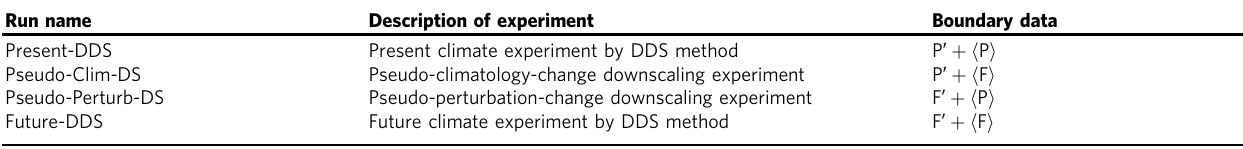
Table 1 Experimental design for estimating the contributions of climatology and perturbation changes and their nonlinear